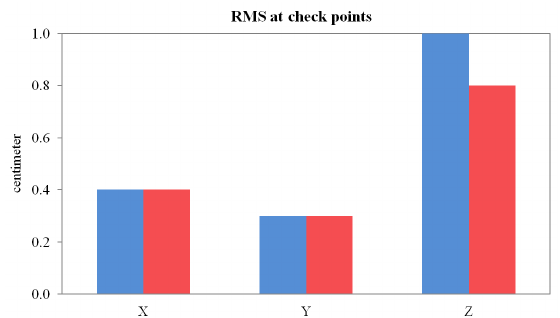
Figure 8. RMS at check points for BHT (blue) and DOE (red)